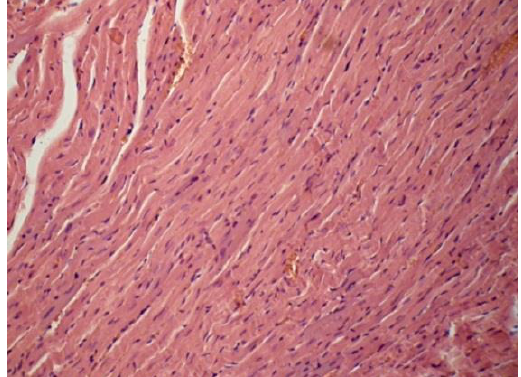
Fig. 10. SHR rat ventricular myocardium. Combined long-term therapy (candesartan and corvitin). Staining with hematoxylin and eosin. Eye. 10×. Lens. 10×.